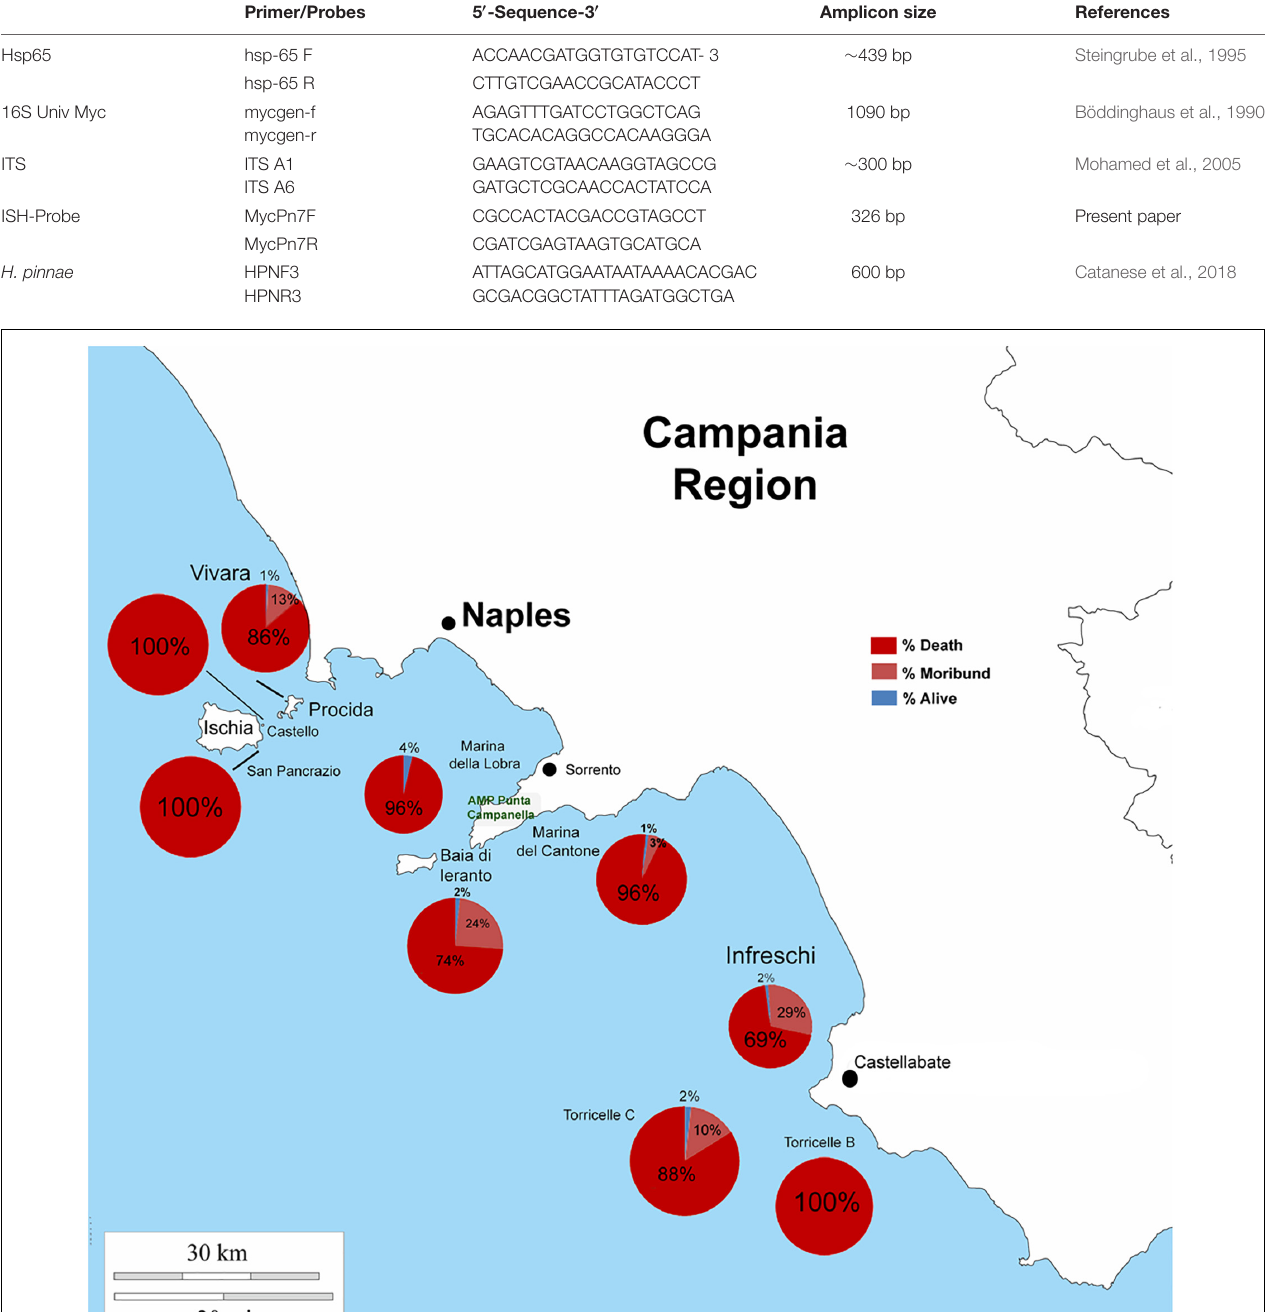
TABLE 1 | Primers used in the study.